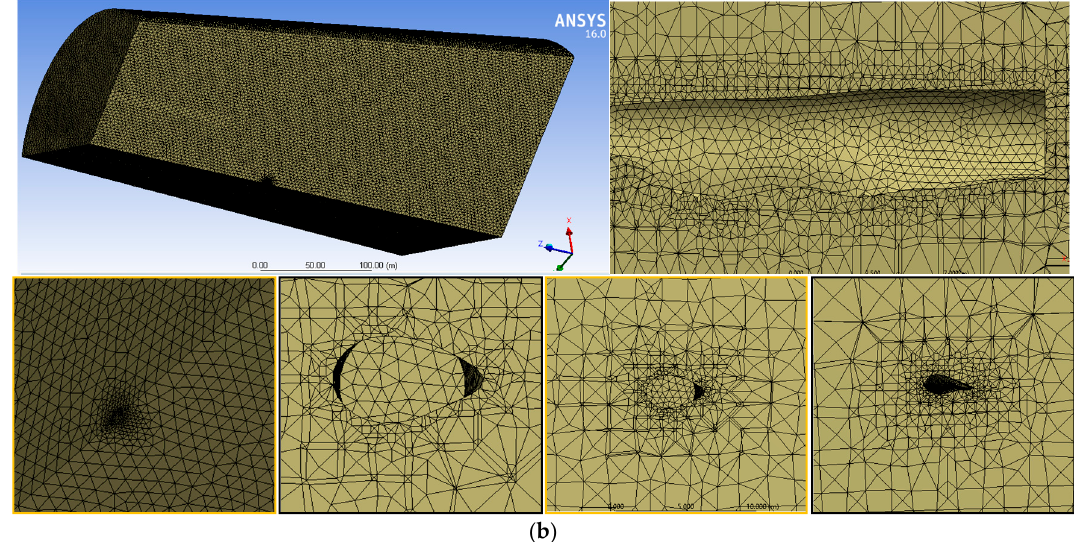
Figure 4. ( a ) Computational domain with boundary conditions and ( b ) meshes for the fluid domain.